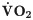
Correlations of the increases in V˙O2 with respiratory rate (A), tidal volume (B), minute ventilation (C), heart rate (D), stroke volume (E), cardiac output (F), and arterial-venous oxygen difference (G) from rest to first threshold.